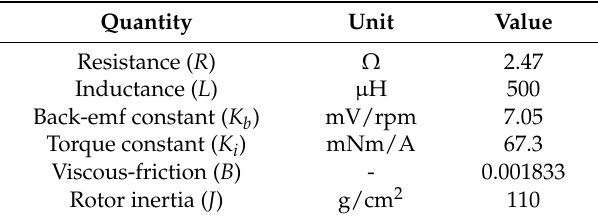
Table 2. Characteristics of the DC generator.